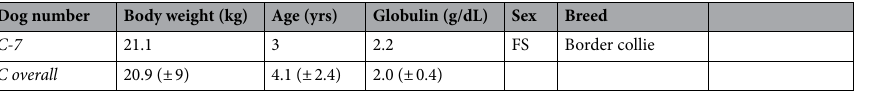
Table 1. Study population characteristics including body weight (kilograms), age (years), globulin (g/dL), sex, relevant mutation status, ARVC type, and ACVIM MMVD stage. Dogs are listed by group: Boxers with ARVC